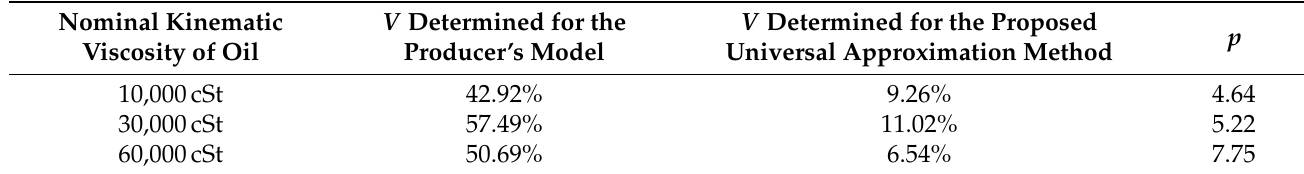
Table 4. Values of the coefficient of residual variation V (universal approximation). Nominal Kinematic V Determined for the V Determined for the